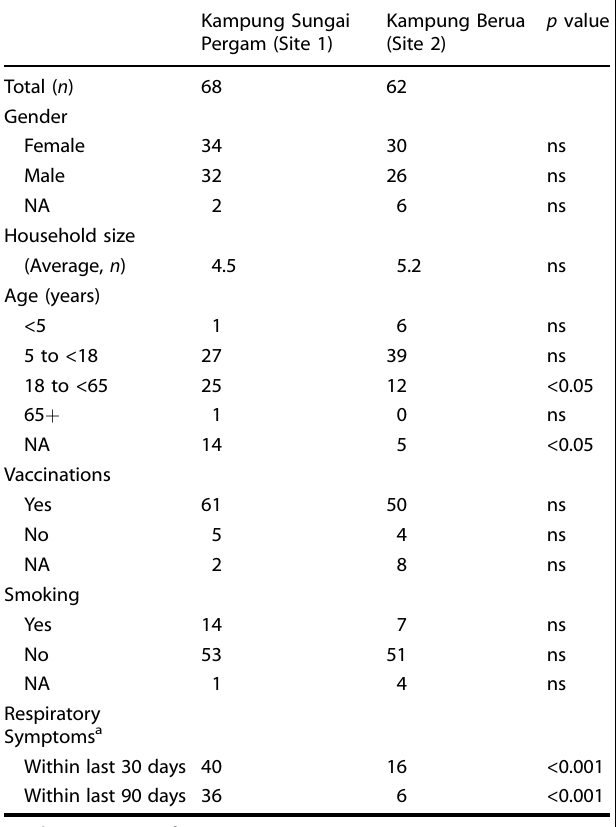
Table 1. Comparison of populations from Kampung Sungai Pergam (Site 1) and Kampung Berua (Site